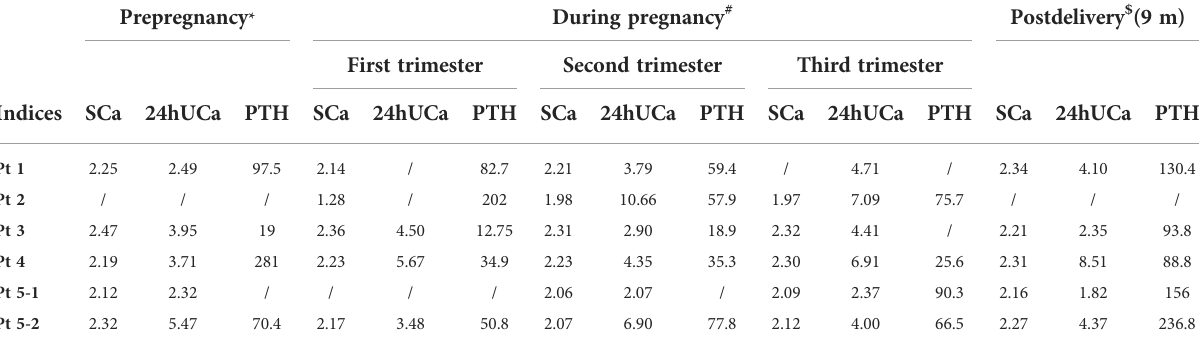
TABLE 2 Changes in serum calcium, 24-h urinary calcium, and serum PTH level during pregnancy and after delivery. Prepregnancy *